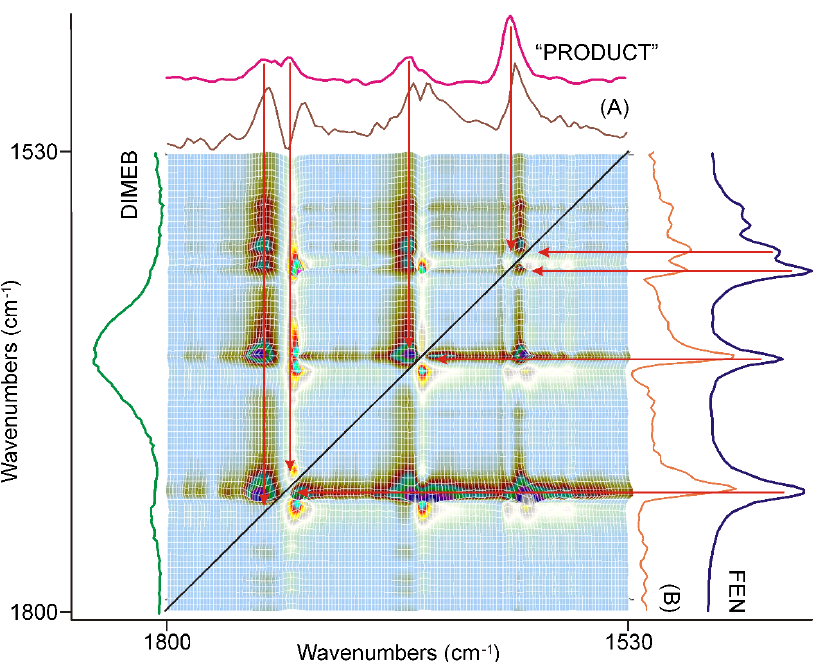
Figure 10. The asynchronous correlation surface calculated from the spectra recorded during the last 20 min was similar to that of the previous 20 min, except for the peaks’ switched sign. The x-axial section taken at 1728 cm − 1 (A) and at 1740 cm − 1 (B) showed that the positive sign of the off-diagonal peaks in the upper-left triangle was attributed to the peaks of “PRODUCT”, and the same in the lower-right triangle to the peaks of FEN, so the intensity changes in this region had an asynchronous component above the synchronous one, at the end of the period.